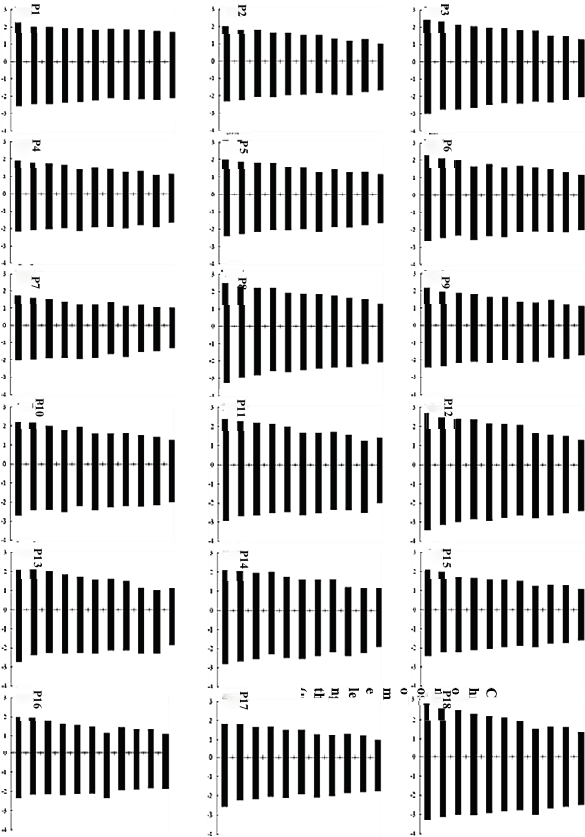
Figure 2. Karyotypes of somatic chromosome complement of 18 Iranian endemic Ferula assa-foetida L. ( n = 2 x = 22) populations. Scale bars = 5 µm.